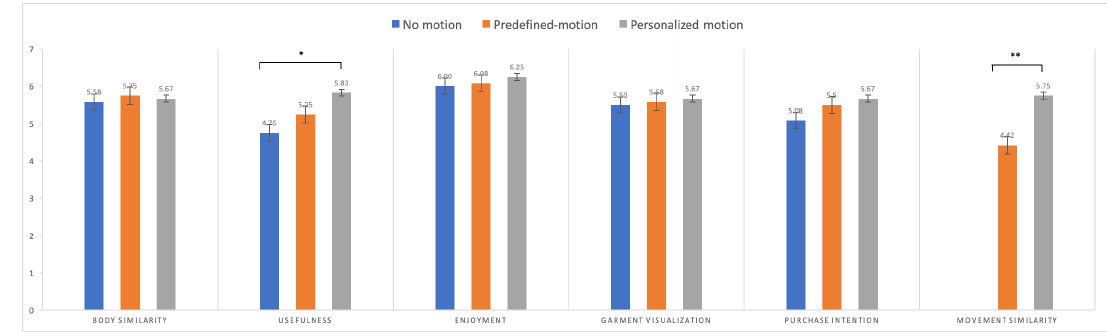
Figure 10. Perceived levels of body similarity, usefulness, garment visualization, purchase intention, and movement similarity. Note: * p < 0.05, ** p <